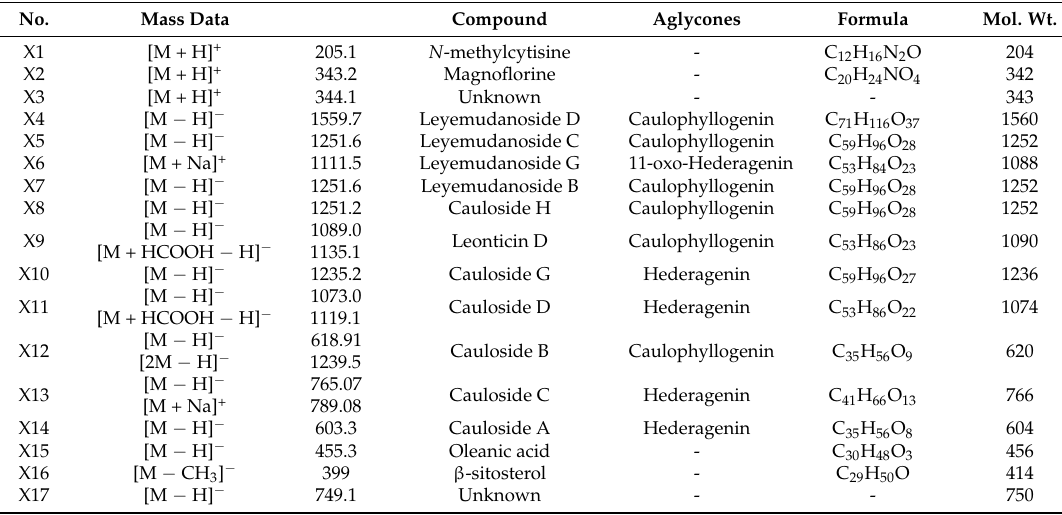
Table 10. Assignments of the correlated peaks.